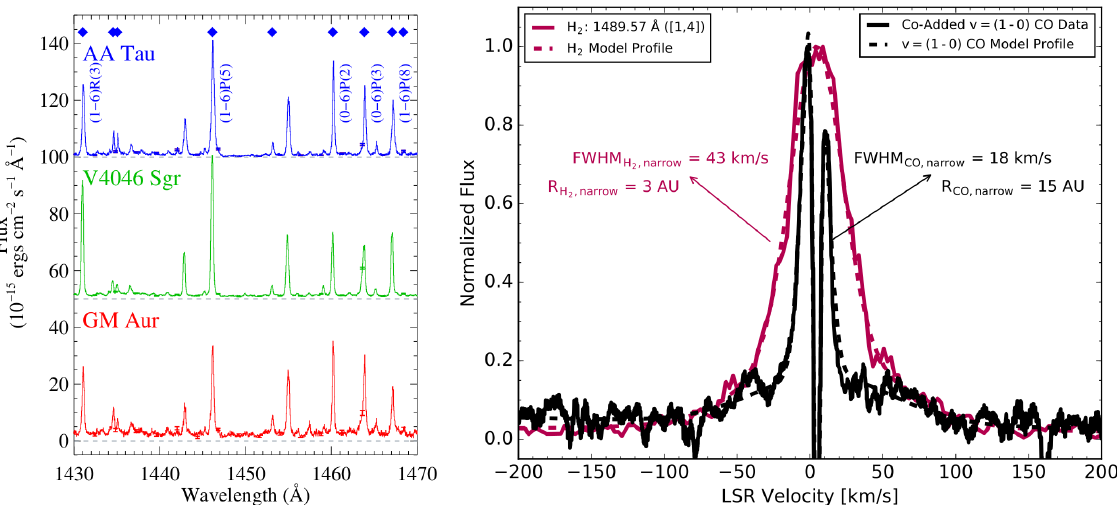
Figure 6. Left : Spectral region of 1430–1470Å for three prototypical gas-rich disks. All of the strong spectral features in this bandpass are emission lines from Ly α -pumped fluorescent H 2 (UV-H 2 ; marked with blue diamonds and several bright features are labeled). From France et al. [79]. Right : Kinematic model for the H 2 emission including the effect of the COS line spread function (LSF). From Arulanantham et al. [84]. Both figures: c AAS. Reproduced with (cid:13)